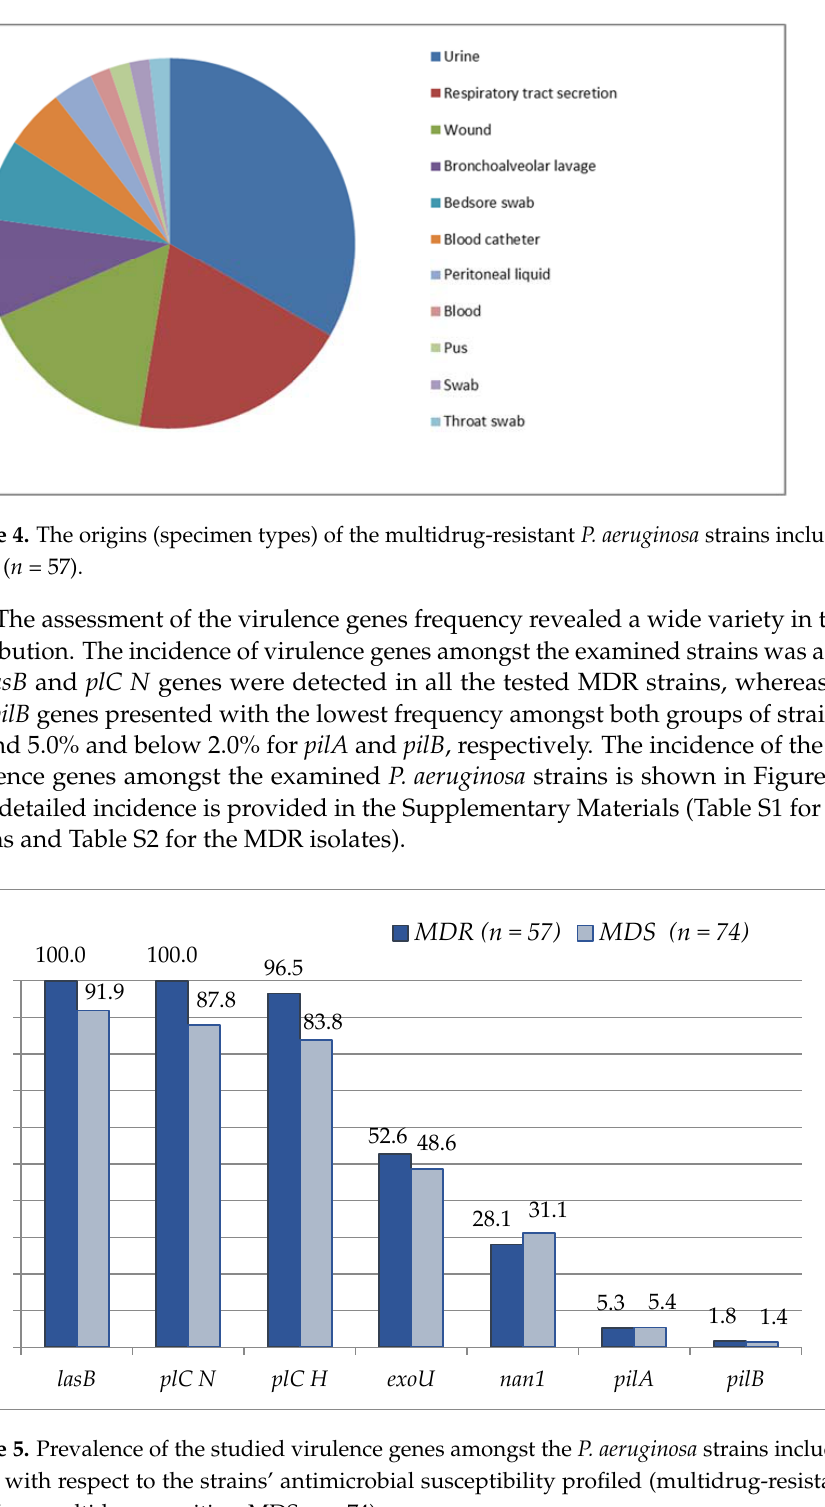
Figure 3. The origins (units) of the multidrug ‐ resistant P. aeruginosa strains included in the study ( n = 57).